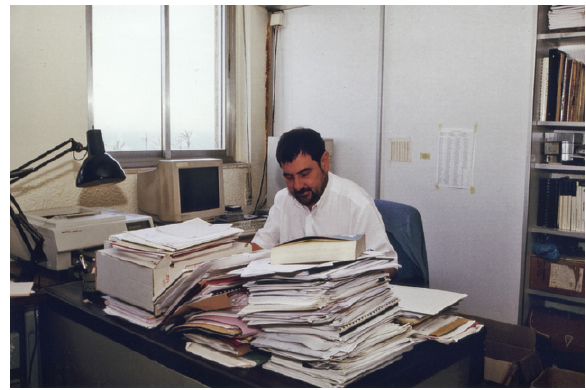
Fig. 2. - Jordi Salat at work in his office in the old IIP building. Source: Emilio Garcia